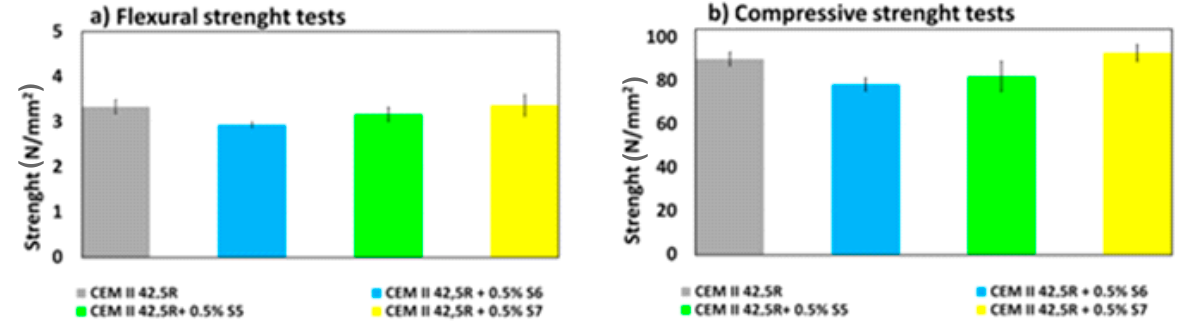
Figure 11. Mechanical properties for ( a ) flexural strength and ( b ) compressive strength of the mortar, as the only reference and the mortar doped with S5 (blue), S6 (green) and S7 (yellow) (Table 1) and at w/c = 0.35 and 1% bwoc after 28 days.